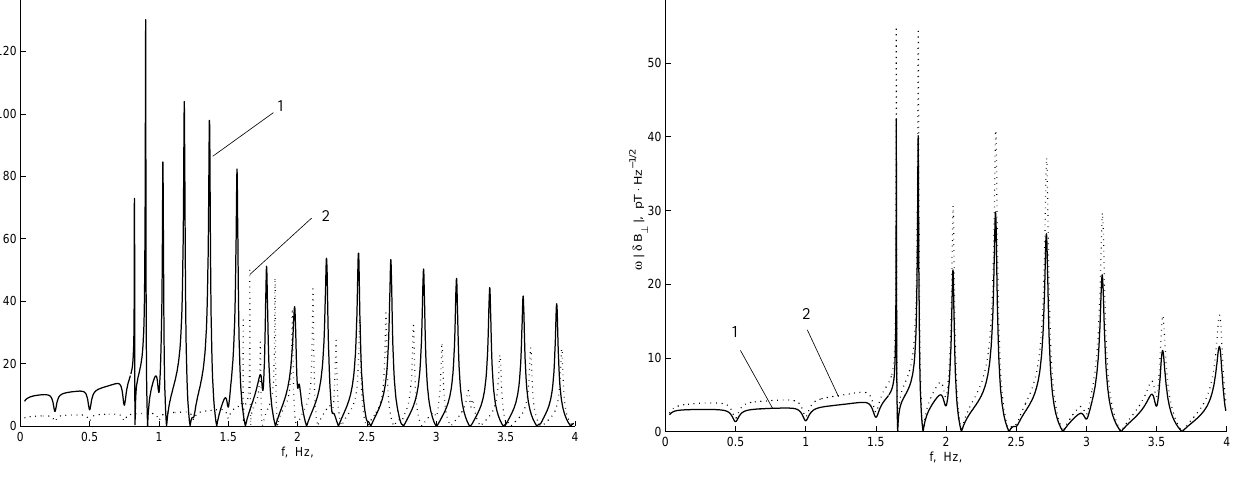
Fig. 5. Same as in Fig. 4 but for L = 10 3 km.